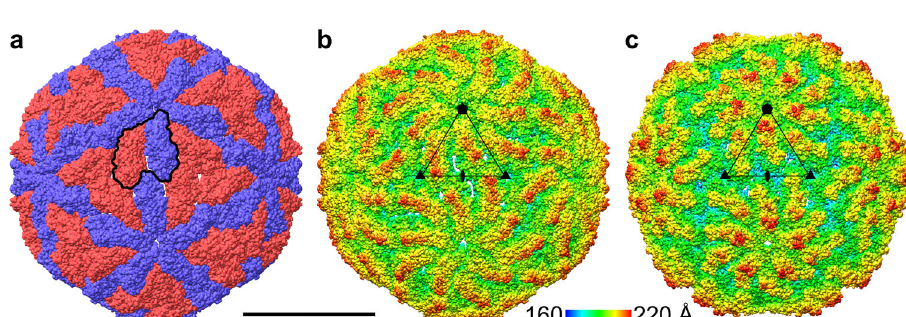
Fig. 2 Comparison of virion structures of L-BC and L-A viruses. a , b Molecular surface representations of L-BC virus. Scale bar 200 Å. a Particle surface is colored according to type of subunit within icosahedral asymmetric unit: A in blue and B in red. The borders of a selected icosahedral asymmetric unit are highlighted with a black outline. b Particle surface is rainbow-colored based on distance from particle center. Positions of selected fi vefold, threefold, and twofold symmetry axes are indicated with pentagon, triangles, and oval, respectively. c Rainbow-colored molecular surface representation of L-A virus (PDB 1M1C). The rainbow scale shows the distance of the molecular surface from the particle center in Table 1). The arrangement of A and B subunits in the icosahedral axes (Fig. 2b, c). The thickness of both L-BC and L-A capsids is asymmetric unit of L-BC was selected to re fl ect the largest 6 nm. The volume of capsid cavity is 18,000 nm 3 for L-BC and interface in L-A virus (Fig. 4a). Virions of L-BC and L-A have 17,000 nm 3 for L-A. The capsid of the L-BC virion contains pores positioned at fi ve- diameters of 38.5 and 37.0 nm, respectively (Fig. 2b, c). The L-A and threefold symmetry axes with diameters of 12 and 9 Å, virus has higher protrusions around fi vefold symmetry axes and respectively (Fig. 4b – g). Furthermore, there are 4- to 7-nm-wide broader depressions around twofold symmetry axes (Fig. 2b, c). crevices in clefts between capsid proteins. Based on homology Overall, the L-BC virus has a smoother capsid surface than L-A. with reoviruses, the pores at fi vefold symmetry axes were The capsid proteins of L-BC form elevated ridges around threefold speculated to serve as channels for the release of transcripts axes, whereas those of L-A protrude around fi vefold symmetry